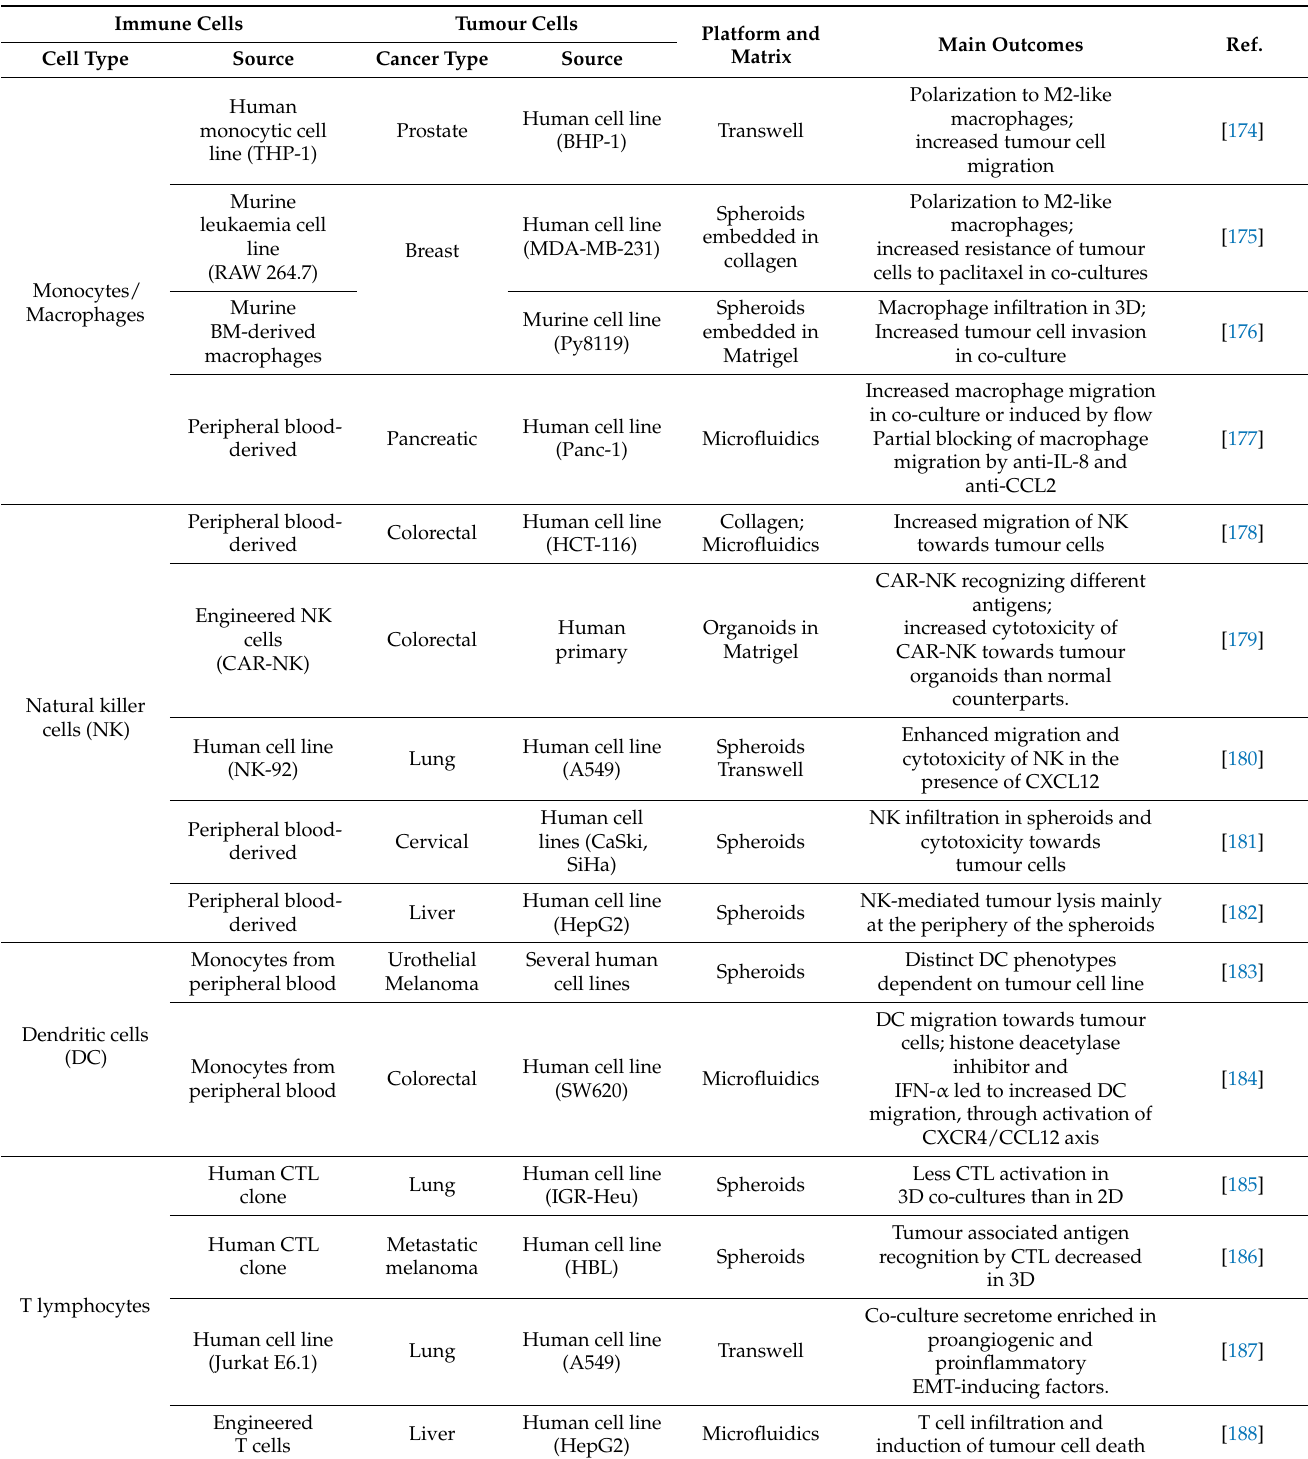
Table 3. Examples of studies developing and employing 3D co-cultures of tumour and immune